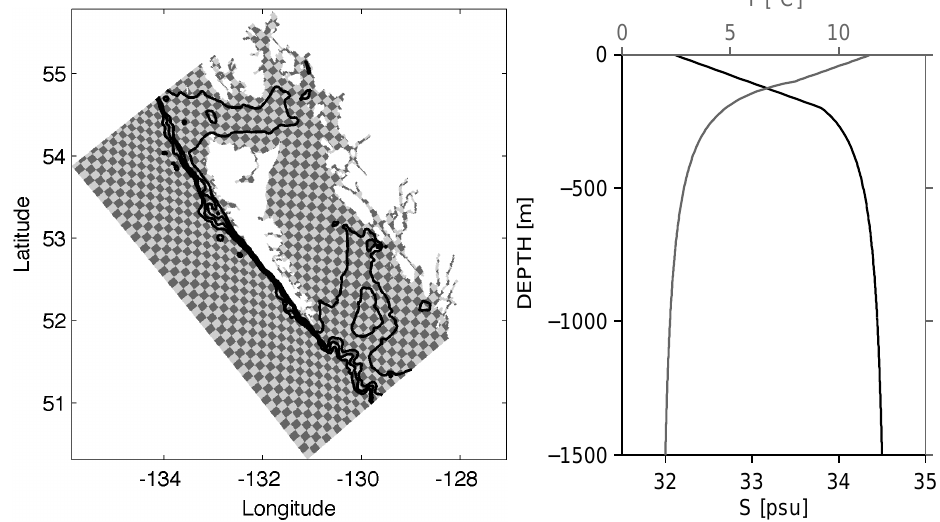
Fig. 2. Alignment of grid over the Queen Charlotte Islands shelf and Sound, every 10th grid point indicated. Stratification is indicated in the right-hand